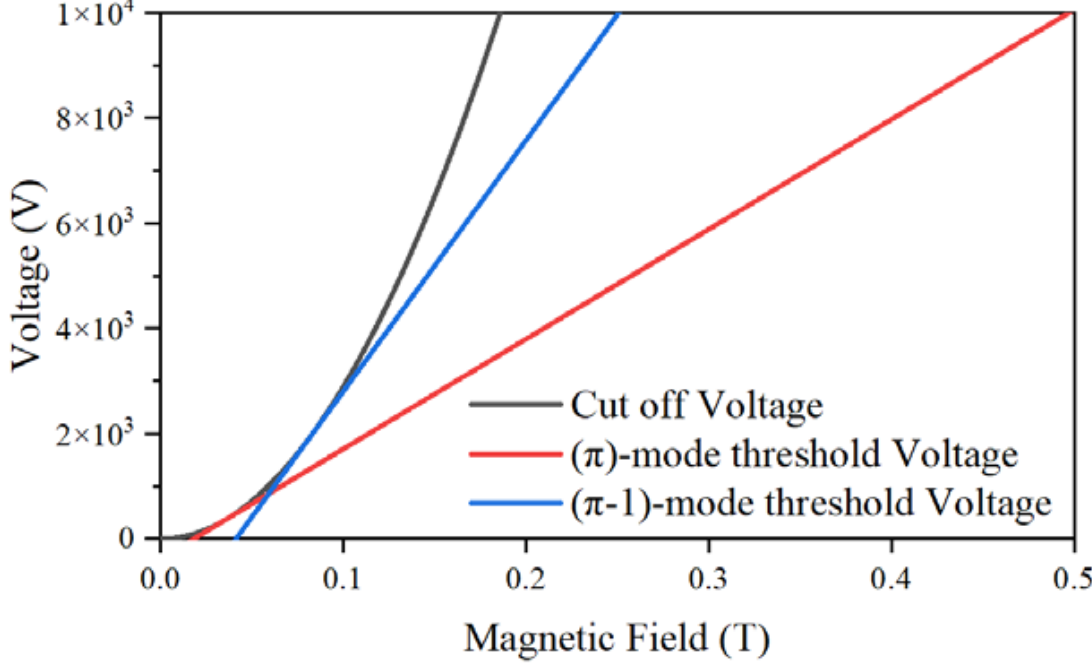
Figure 3. The relation curve of anode voltage and magnetic field in 2.45 GHz CW magnetron with 12 vanes.